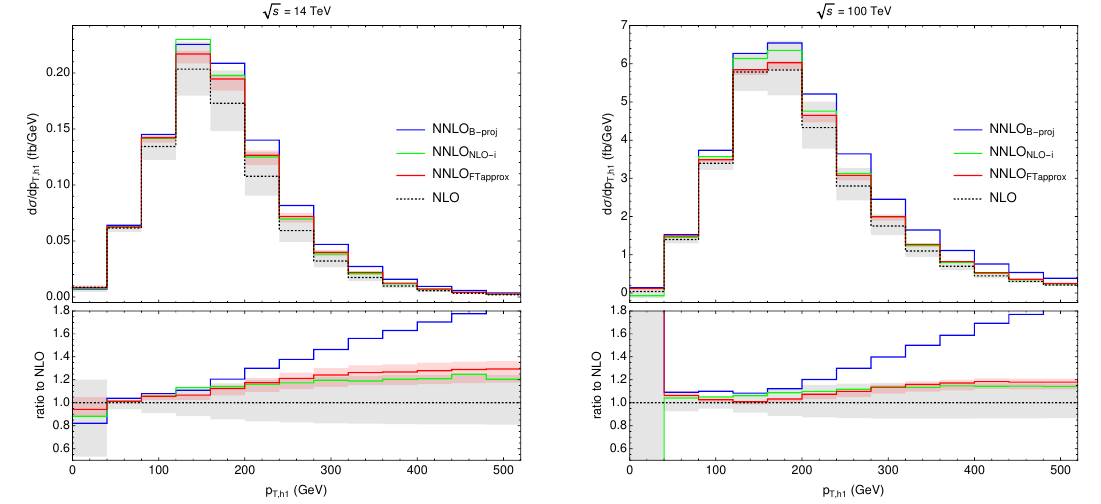
Figure 6 . Transverse momentum distribution for the harder Higgs boson at 14 TeV (left) and 100 TeV